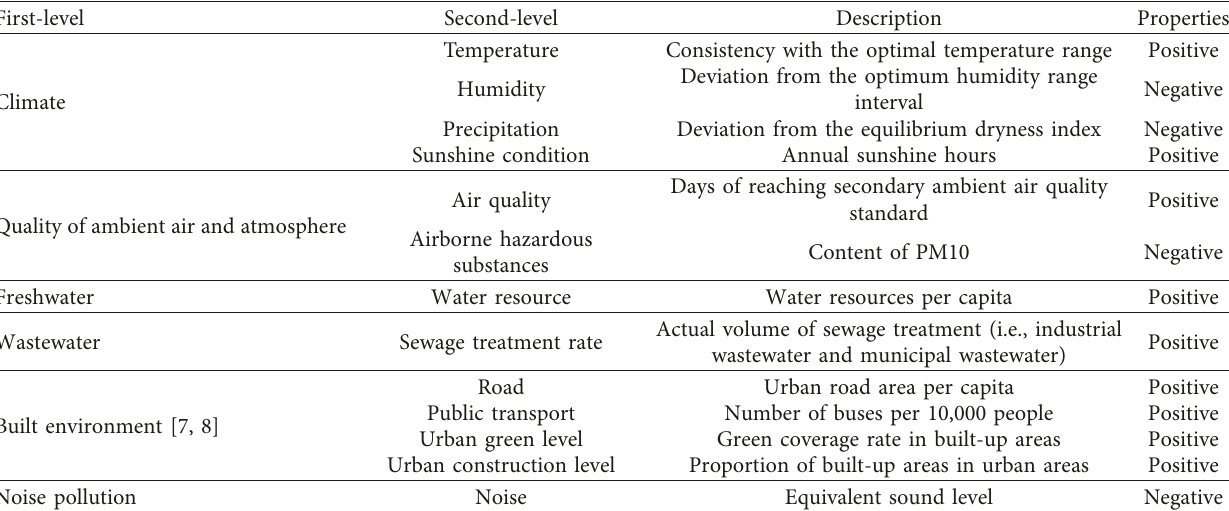
Table 1: The UPE indicator